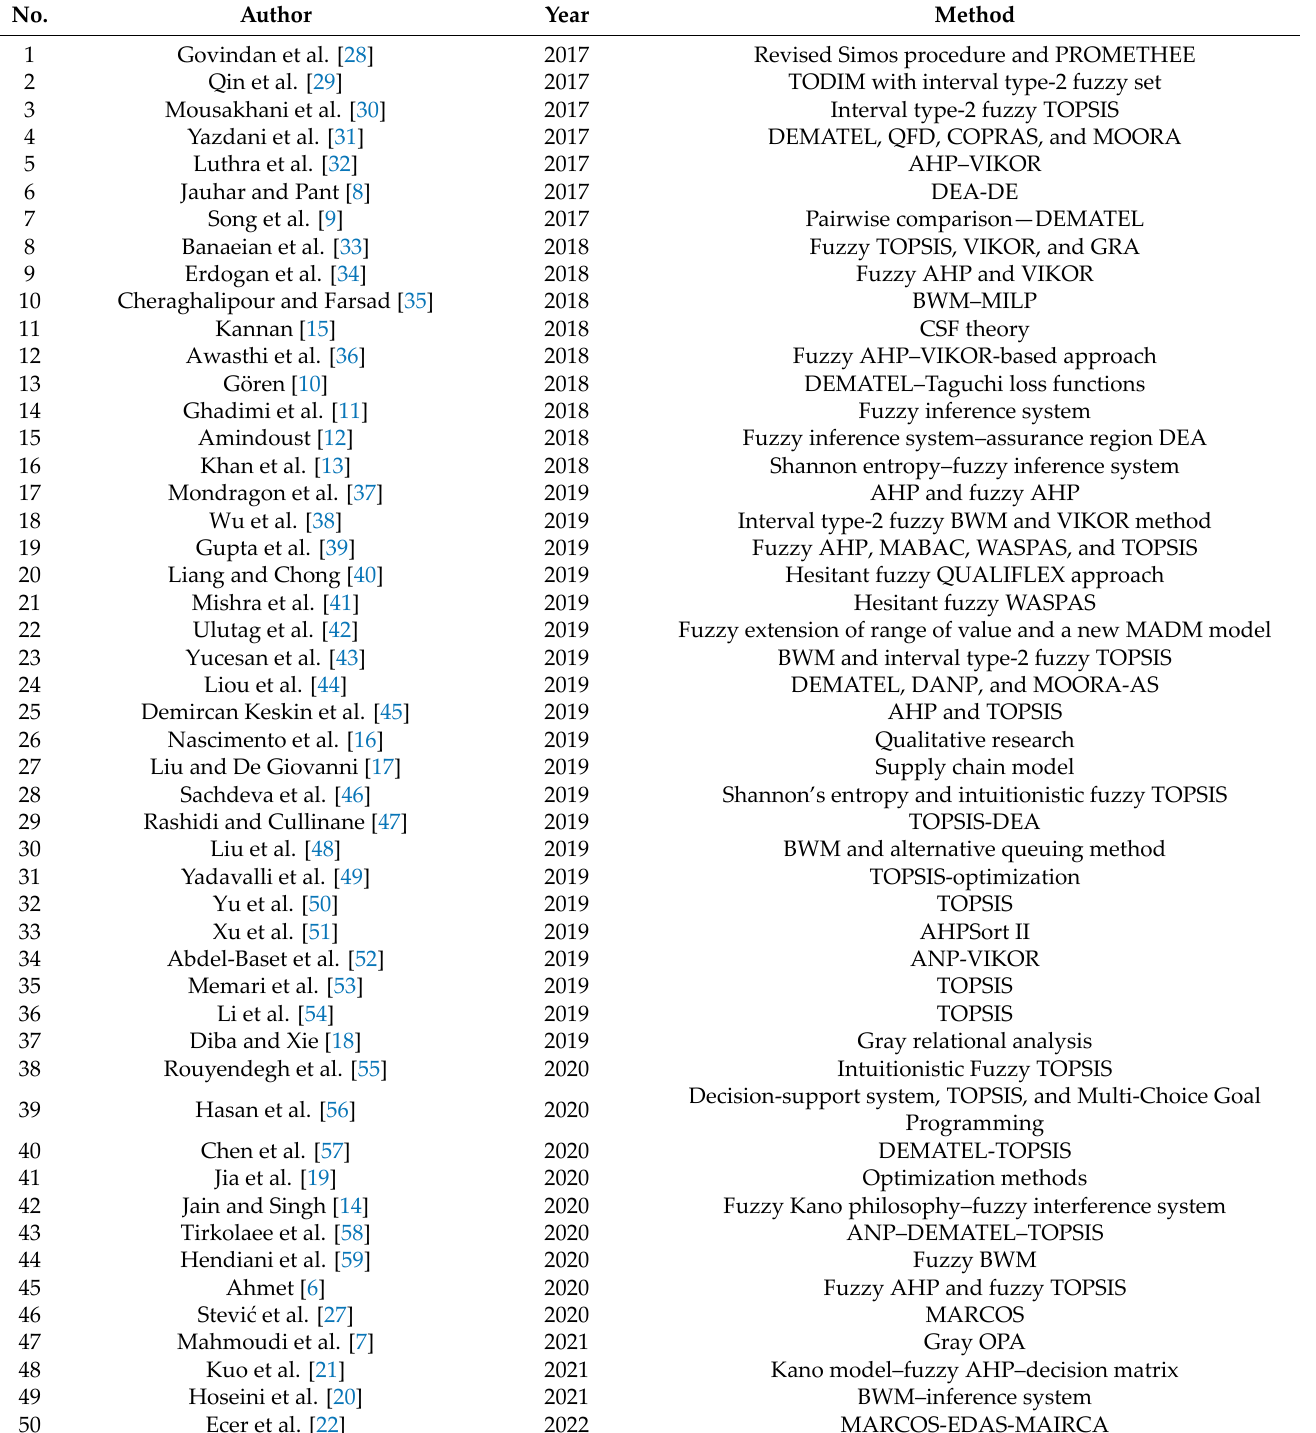
Table 2. The summary of relevant literature on sustainable supplier selection